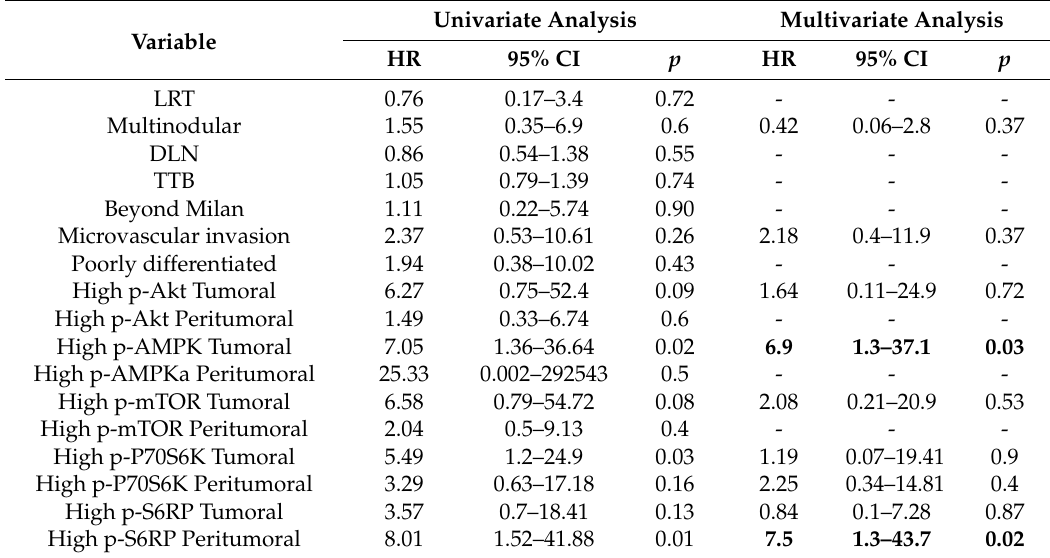
Figure 4. Kaplan-Meier curves showing the impact of the over-expression of selected mTOR pathway components within the tumour tissue on tumour recurrence after liver transplantation: ( A ) p-Akt, ( B ) p-AMPK, ( C ) p-70S6K and ( D ) p-S6RP. Table 4. Univariate and multivariate Cox’s regression analyses. Variables included in the final multivariate model are highlighted in bold.